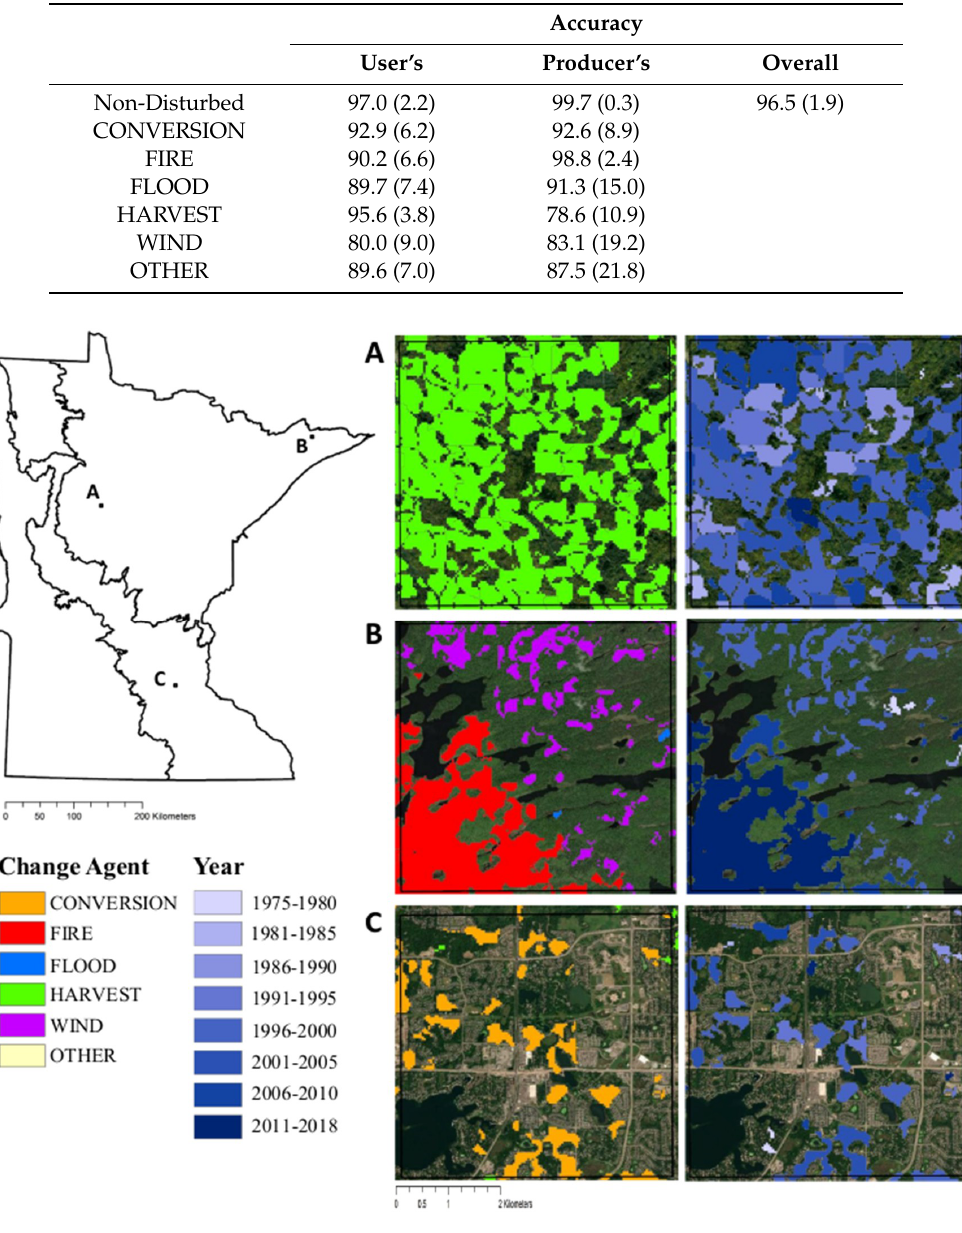
Figure 2. Example insets of most recent fast disturbances within Minnesota by disturbance agent classifications and time since disturbance classes. Inset ( A ) falls within a mosaic of public land ownership, ( B ) is located within the Boundary Waters Canoe Wilderness Area, and ( C ) is within the twin cities developed area of Minneapolis and St. Paul.